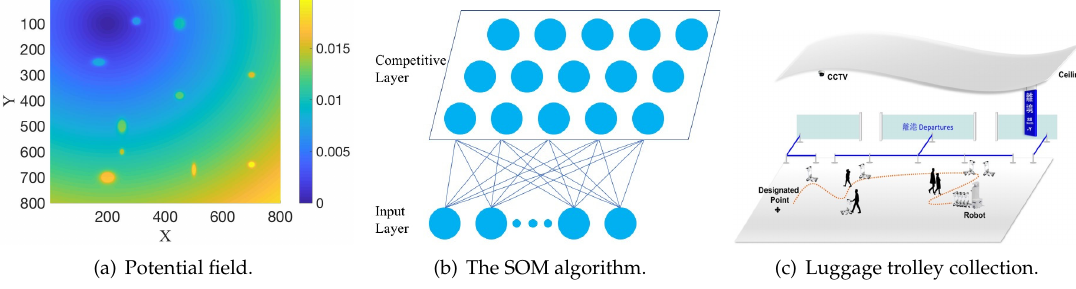
Figure 1. The framework of the robotic autonomous luggage trolley collection at